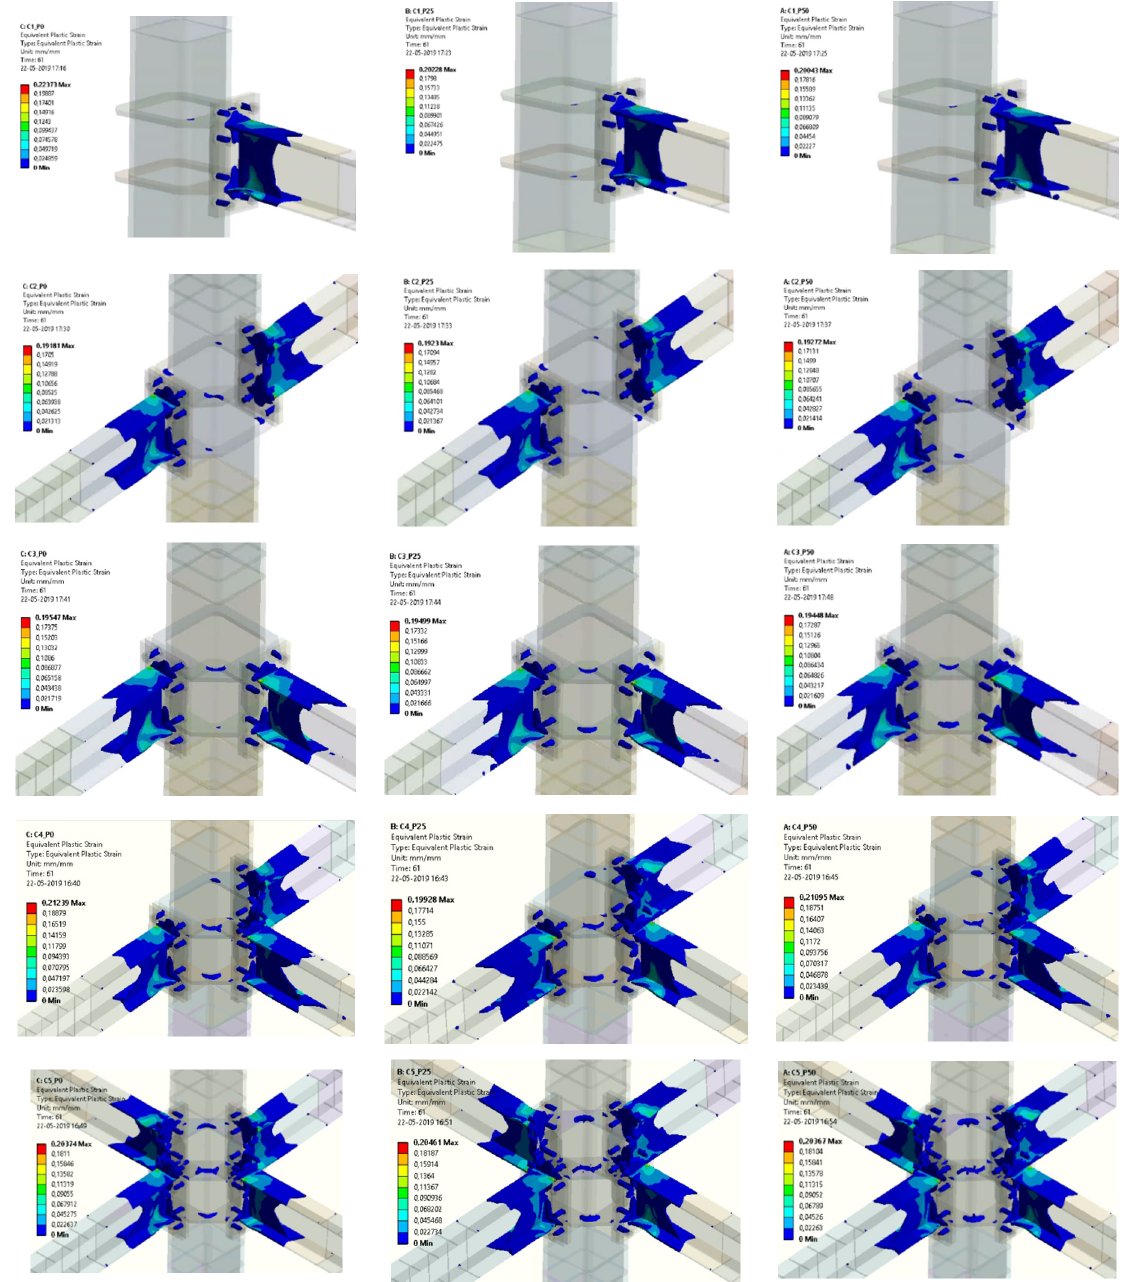
Figure 11. Distribution of plastic strains in joints.